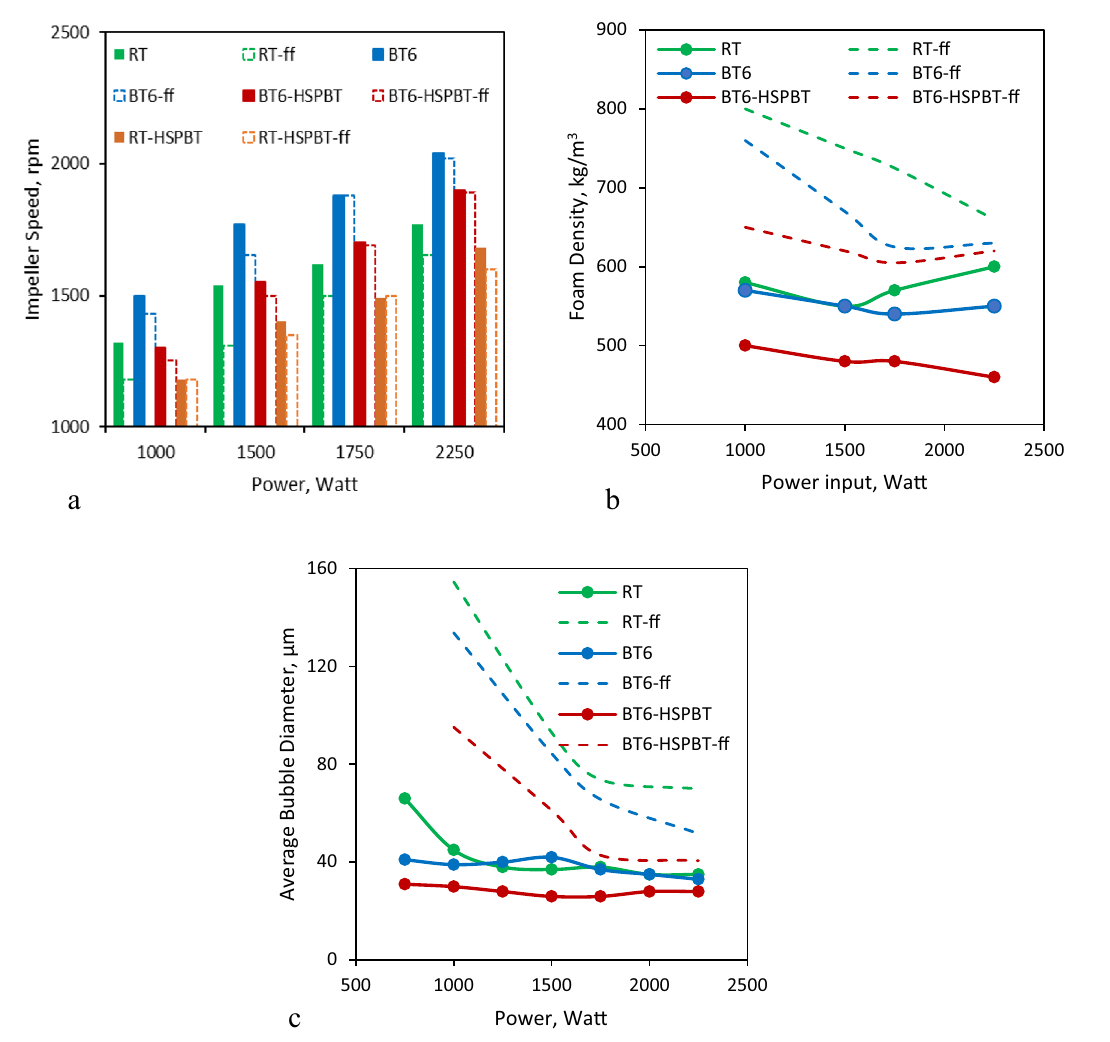
Fig. 7 Effect of addition of fibers on a impeller speed, b foam density and c bubble size with different impeller